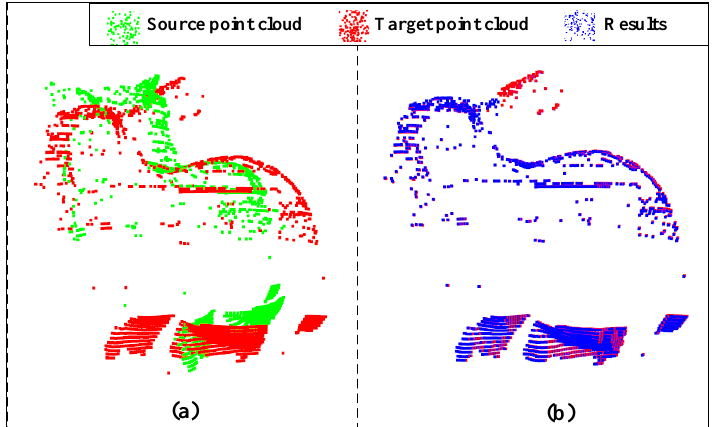
Figure 13. Registration results of Stanford bunny model: ( a ) input; ( b ) result error (R): 0.3403; Error(t):